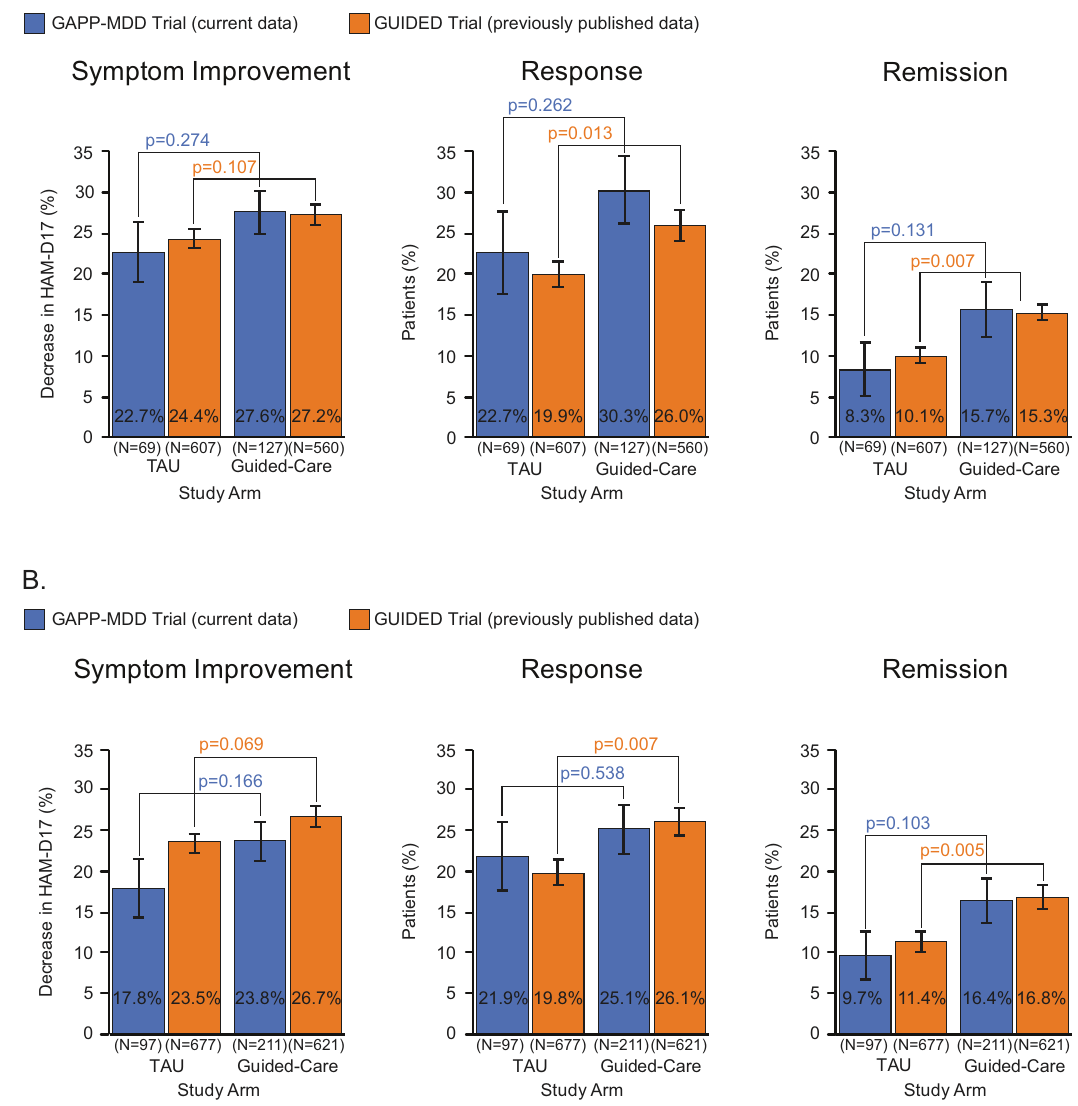
Fig. 1 HAM-D17 clinical outcomes at 8 weeks by treatment arm in the GAPP-MDD clinical trial and the previous GUIDED trial [14]. A Per- protocol (PP) cohort. GAPP-MDD trial: Guided care arm N = 127, TAU arm N = 69; GUIDED trial: Guided care arm N = 560, TAU arm N = 607. B Intent- to-treat (ITT) cohort. GAPP-MDD trial: Guided care arm N = 211, TAU arm N = 97); GUIDED trial: Guided care arm N = 621, TAU arm N = 0.17 – 6.49; p = 0.039) from baseline to week 8 or 10 for guided-